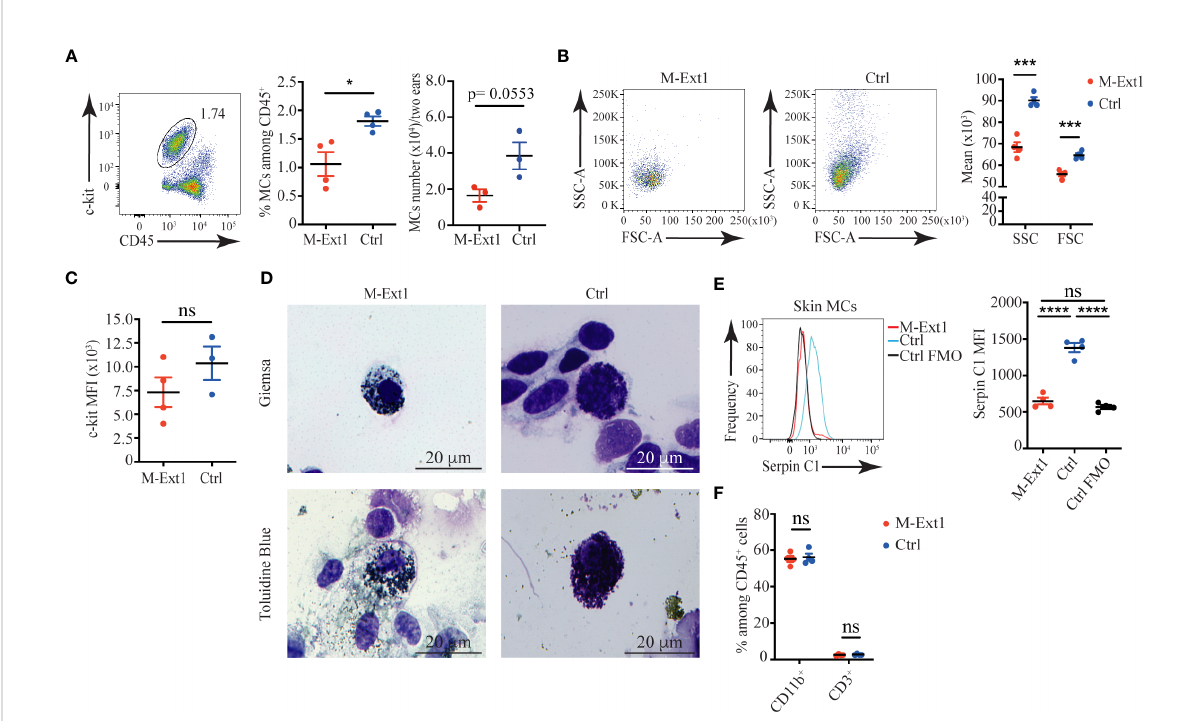
FIGURE 3 Reduced numbers and granularity in 14-weeks old M-Ext1 skin MCs. (A) Representative gating strategy, percentages, and numbers of skin MCs in M-Ext1 and control mice. (B) Representative dot plots and graphs of geometric means of size (FSC) and granularity (SSC) of skin MCs. (C) Mean fl uorescent intensity of c-kit expression in skin MCs in M-Ext1 and control mice. (D) Representative Giemsa and Toluidine Blue staining of c-kit-magnetic beads enriched skin MCs from M-Ext1 and control mice. (E) Representative histograms and statistics of mean fl uorescent intensity (MFI) of Serpin C1 binding to fi xed and permeabilized skin MCs from M-Ext1 and control mice. (F) Percentages of CD11b + and CD3 + cells in the skin from M-Ext1 and control mice. Results are represented as mean ± SEM. Each symbol in the graphs is an individual mouse. Flow cytometry plots in (A – C , E) are representative of 4 individual experiments. Images in (D) are representative of 3 individual mice of each genotype. Statistical signi fi cance was determined by unpaired Student ’ s t-test. Values of p<0.05 were considered statistically signi fi cant, *p < 0.05, ***p < 0.001, ****p < 0.0001, ns, not signi fi